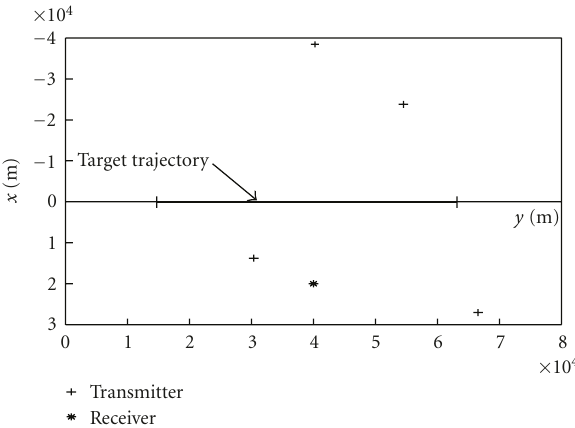
Figure 3: Transmitters and receiver locations and target trajectory.